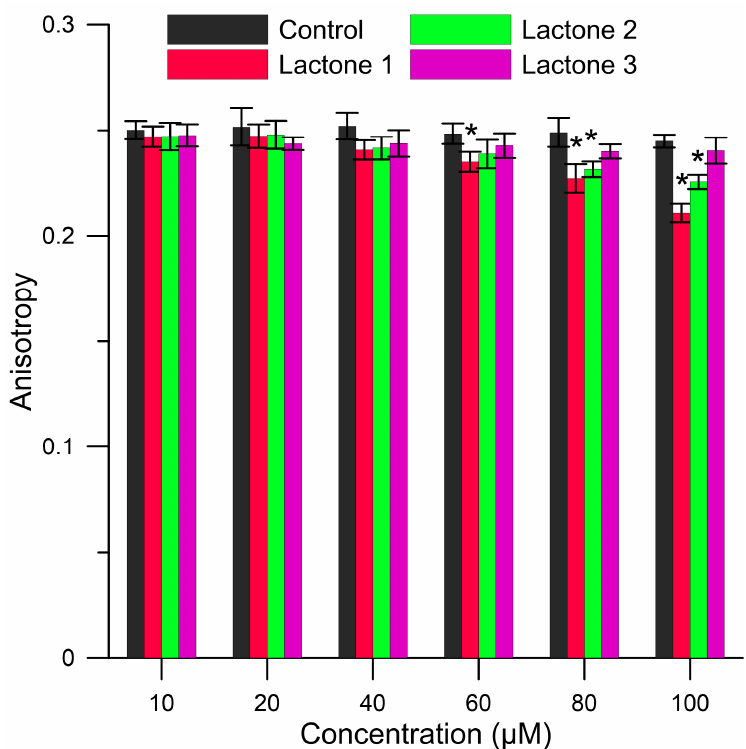
Figure 4. Values of anisotropy (A) of 1,6 ‐ diphenyl ‐ 1,3,5 ‐ hexatriene (DPH) probe for red blood cells membranes (RBCMs; control) and RBCMs with addition of lactones 1 – 3 at 37 °C. Values are mean ± Standard Error of the Mean (SEM). Means labeled with asterisk (*) are significantly ( p < 0.05) different from control.